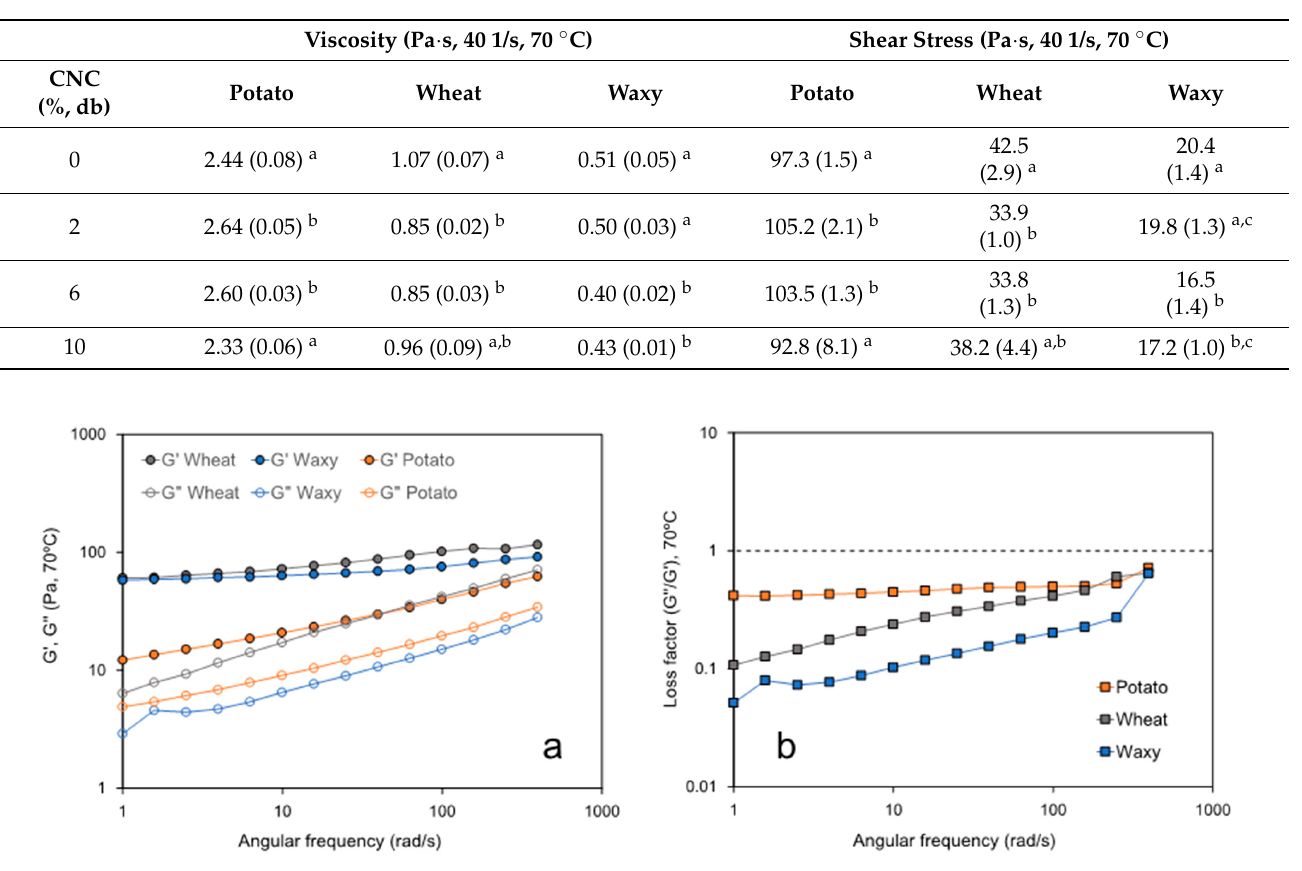
Figure 4. G (cid:48) and G” ( a ) and loss factor (G”/G (cid:48) ) ( b ) assessed as a function of angular frequency in Figure 4. G’ and G’’ ( a ) and loss factor (G’’/G’) ( b ) assessed as a function of angular frequency in gelatinized starch samples at 70 ◦ gelatinized starch samples at 70 °C.